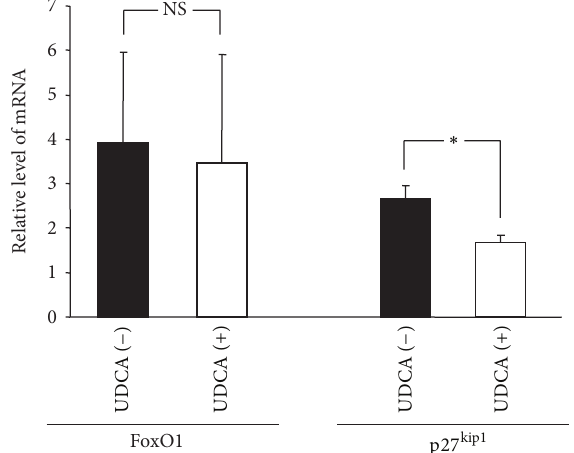
Figure 4: Expression of FoxO1 and p27 kip1 mRNAs in patients with non-cirrhotic PBC who were and were not treated with UDCA (13– 15mg/kg/d). Bars indicate the mean ± SEM ( 𝑃 < 0.05 ; NS: non